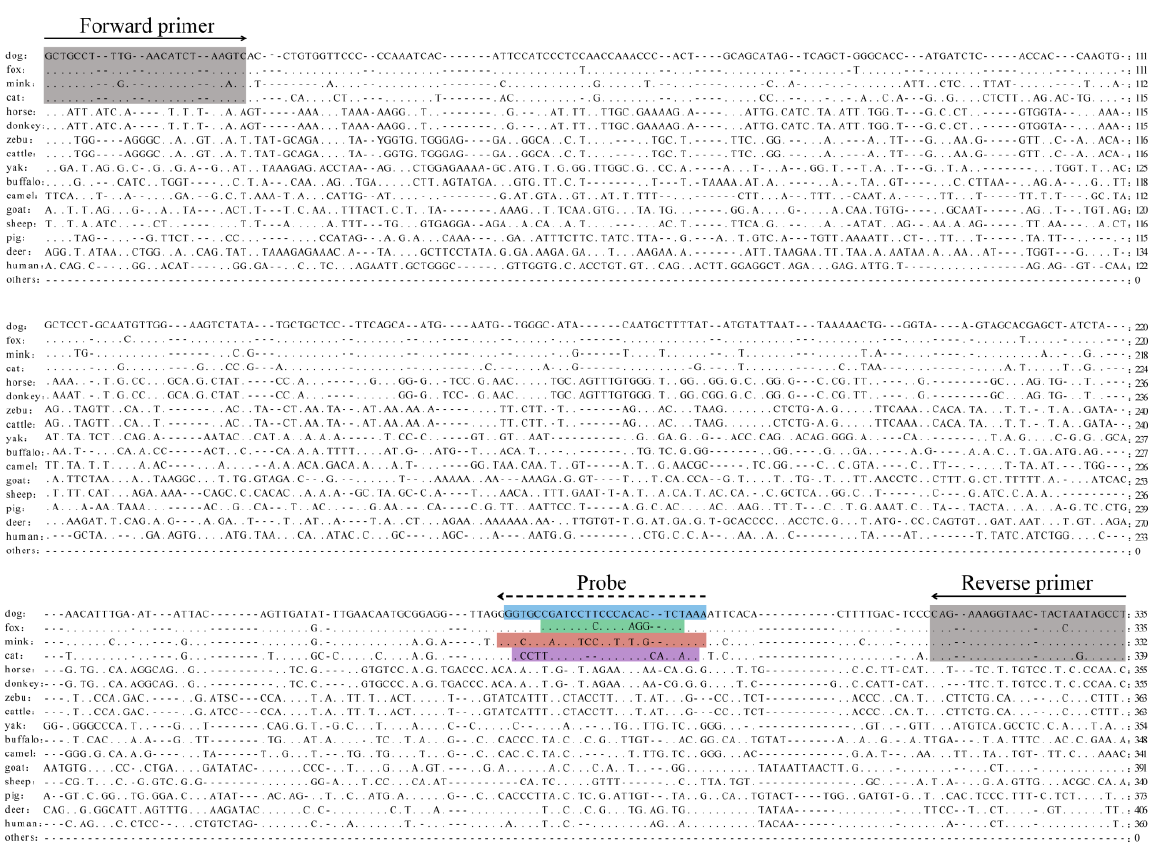
Figure 1. ClustalW multiple sequence alignment of the nuclear DNA target sequences against 44 target and non-target species. The gray shaded areas are the primer-binding regions. The colored shaded areas are the probe-binding regions of cats, dogs, foxes and minks.